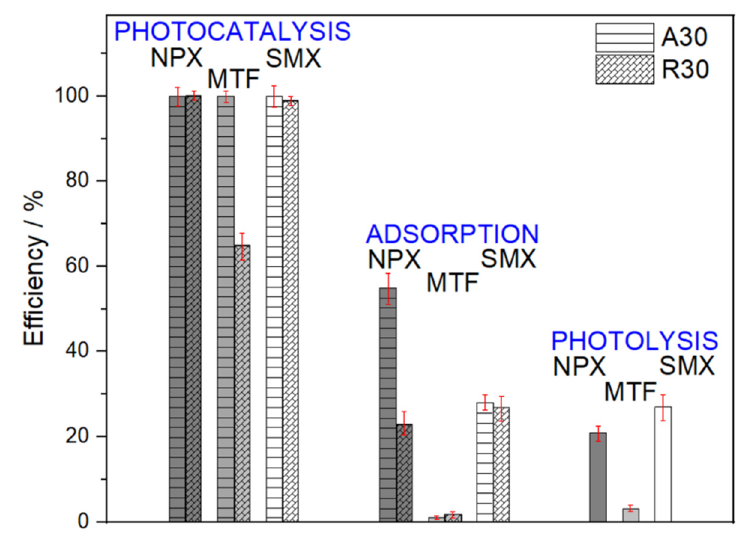
Figure 2. Comparison of the removal efficiencies of photocatalysis, adsorption and photolysis (all after 5 h) for naproxen (NPX), sulfamethoxazole (SMX) and metformin (MTF).